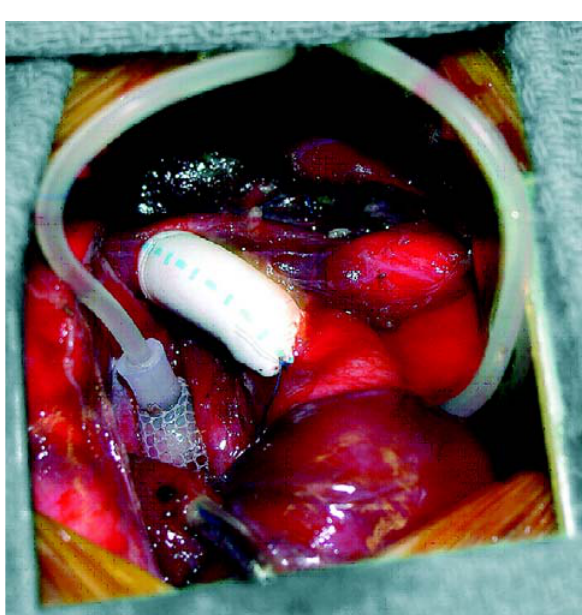
Fig. 3 - Detalhe do Blalock-Taussig "reverso" com tubo de PTFE 6 mm, entre o tronco pulmonar e artéria inominada, realizado através de esternotomia mediana